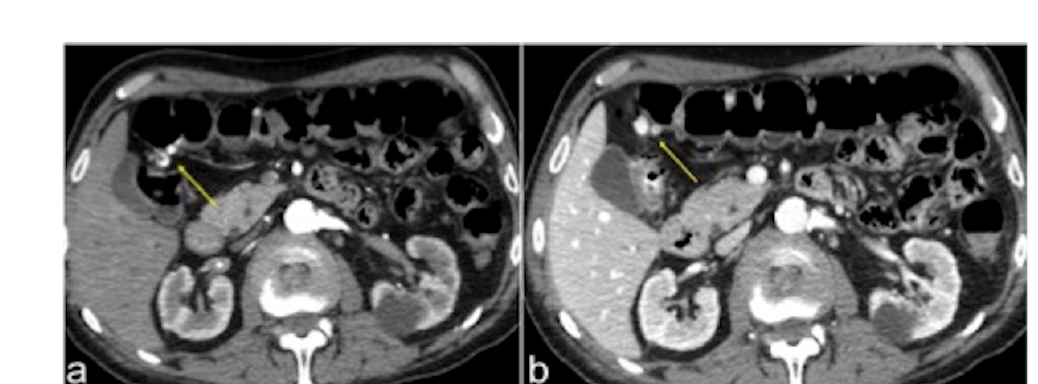
Figure 33. CTA multiphasic study in the arterial ( a ) and venous ( b ) phases of diverticular bleeding; a